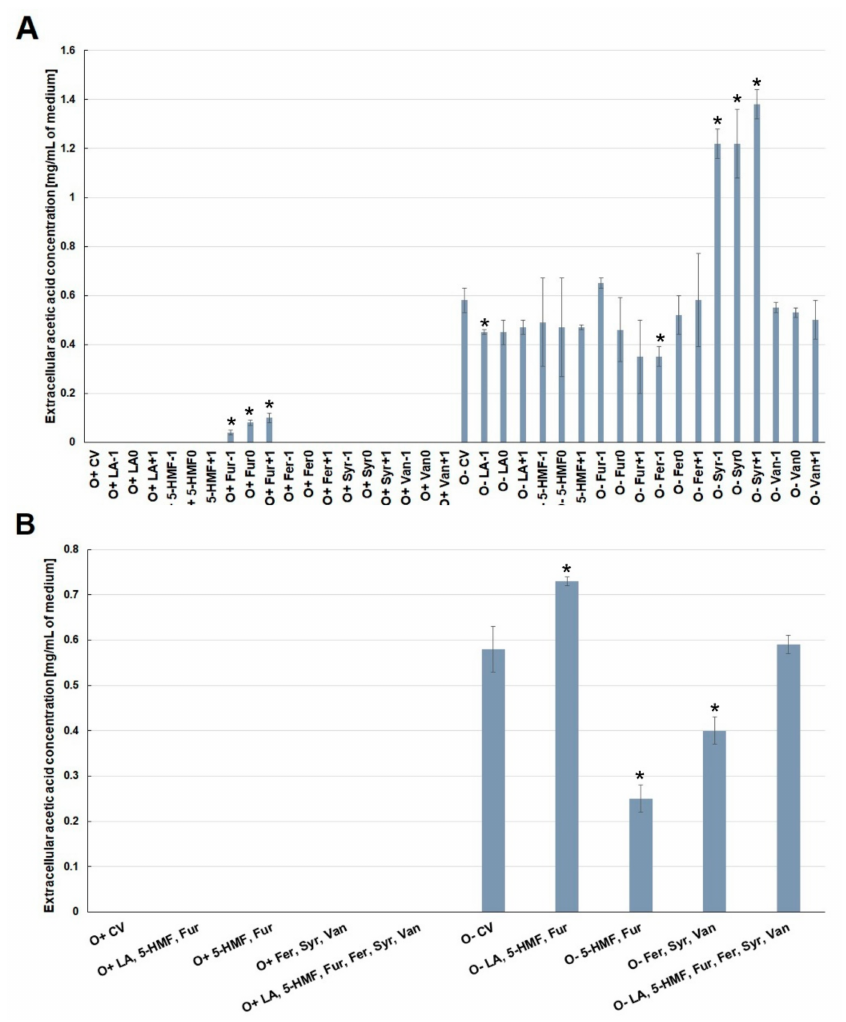
Figure 7. Effect of lignocellulose pretreatment by-products ( A , B ) on the production of extracellular acetic acid by yeast (*—statistically different from the corresponding control variant α <